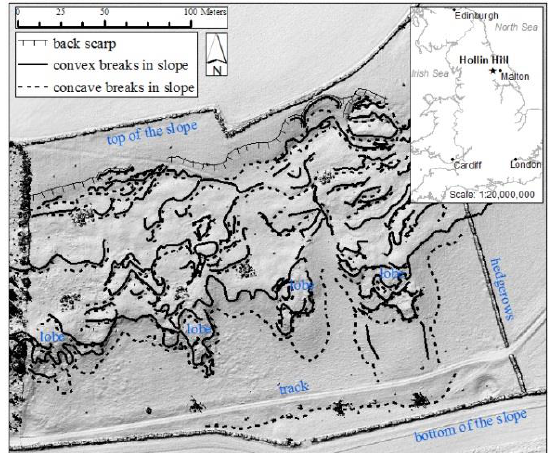
Figure 1. Geomorphological map of Hollin Hill landslide. Inset map locates the site within the UK (Merritt et al.,